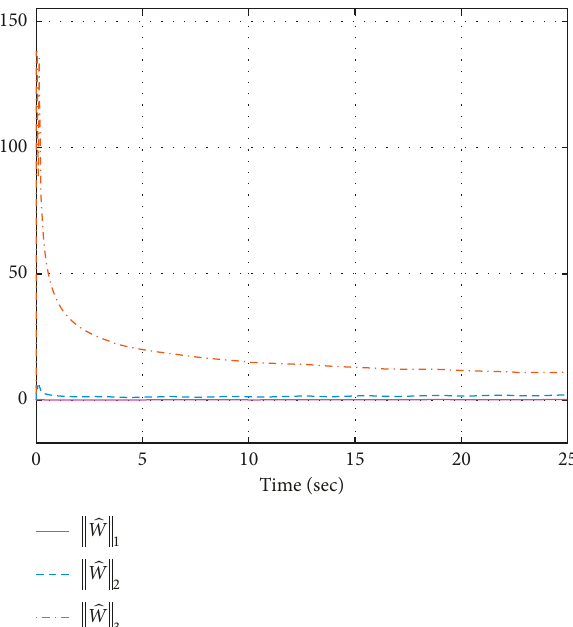
Figure 9: Evolution of the norm of the fuzzy logic system parameters.